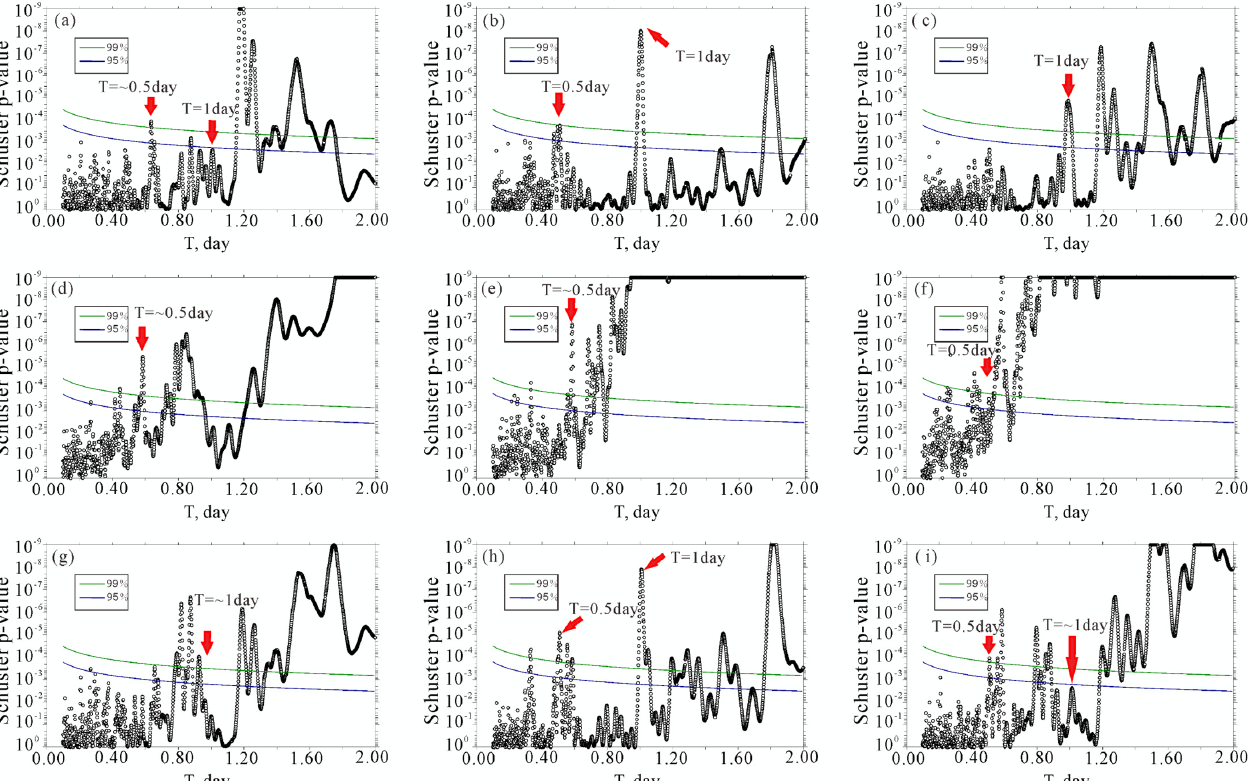
Figure 6. Schuster spectra for different subsets: ( a ) 0 < M < 5 and 0 < depth < 30 km; ( b ) M ≥ 5 and 0 < depth < 30 km; ( c ) any M and 0 < depth < 30 km; ( d ) 0 < M <5 and depth ≥ 30 km; ( e ) M ≥ 5 and depth ≥ 30 km; ( f ) any M and depth ≥ 30 km; ( g ) 0 < M < 5 and any depth; ( h ) M ≥ 5 and any depth; ( i ) any M and any depth. The red arrows indicate distinct periods; 99% and 95% confidence levels correspond to 1% and 5% of the minimum Schuster p -value, respectively.